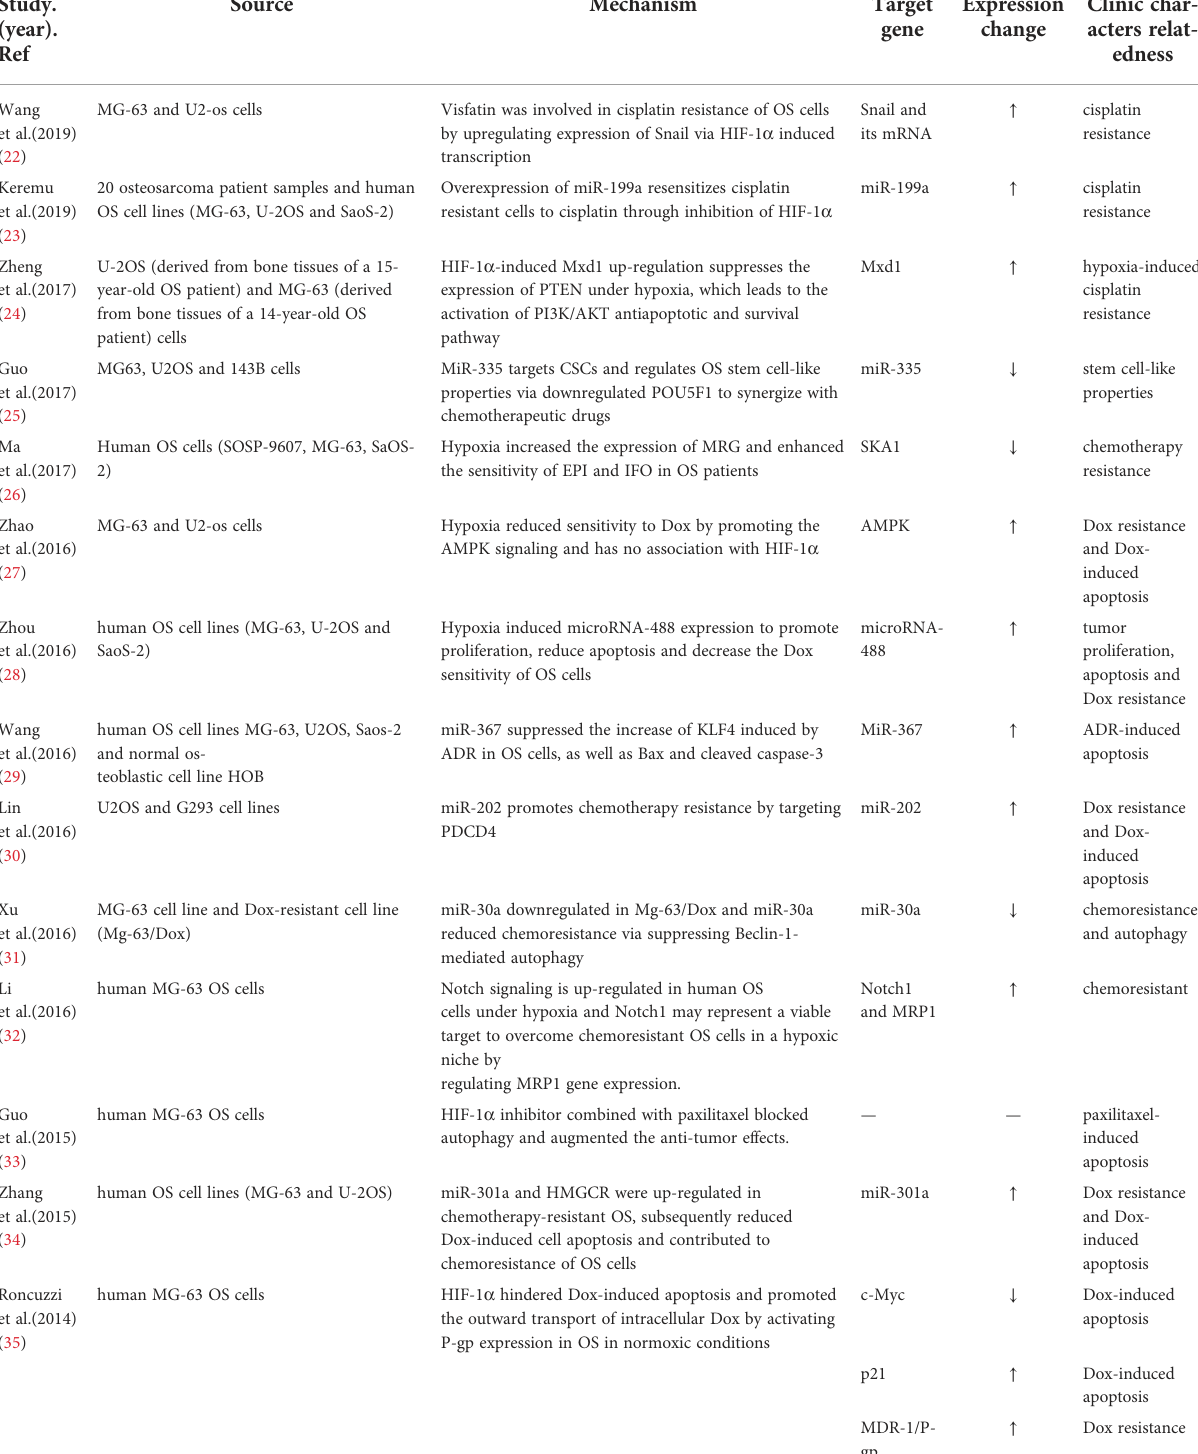
TABLE 2 A schematic diagram of the expression of hypoxic and drug resistance factors. Study.